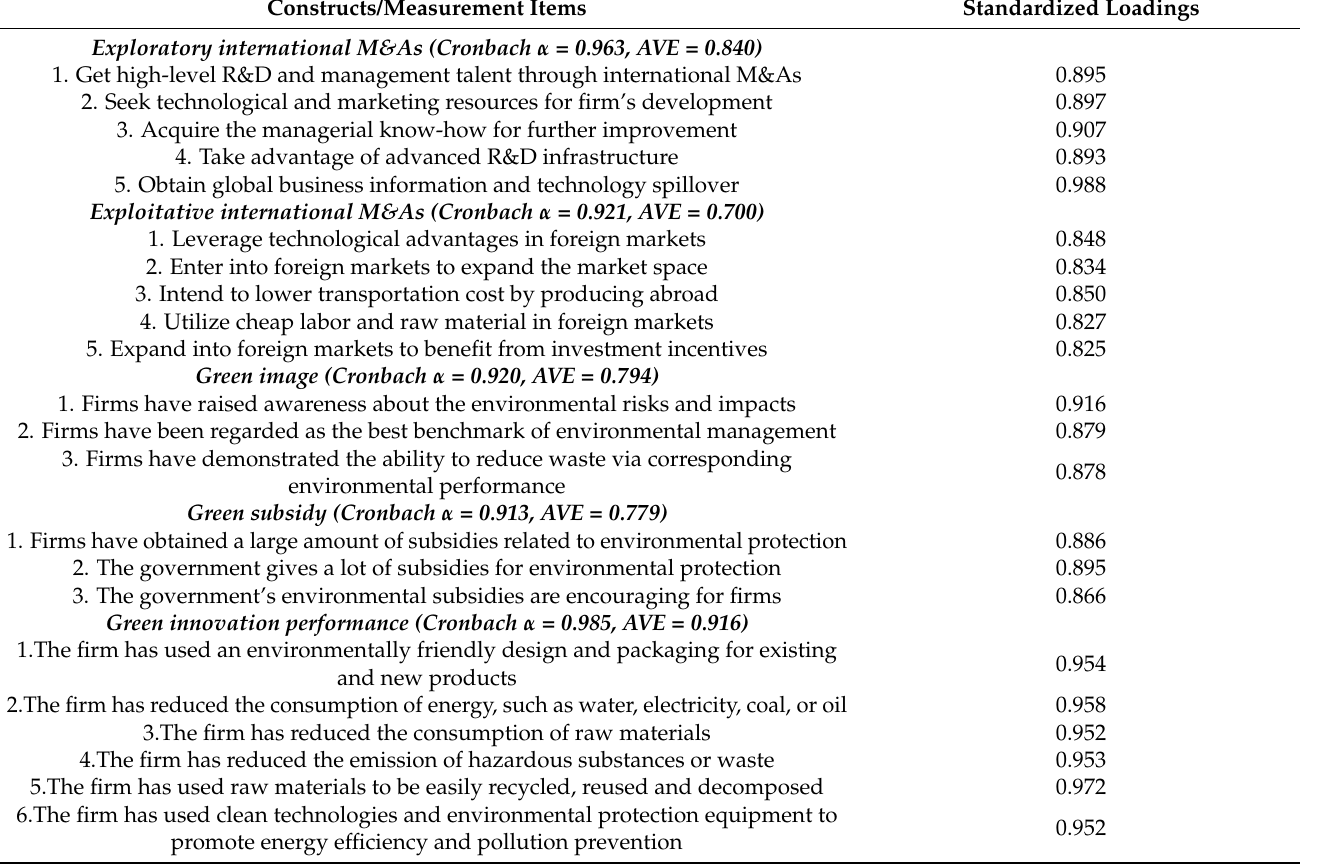
Table 1. Construct measurement and confirmatory factor analysis